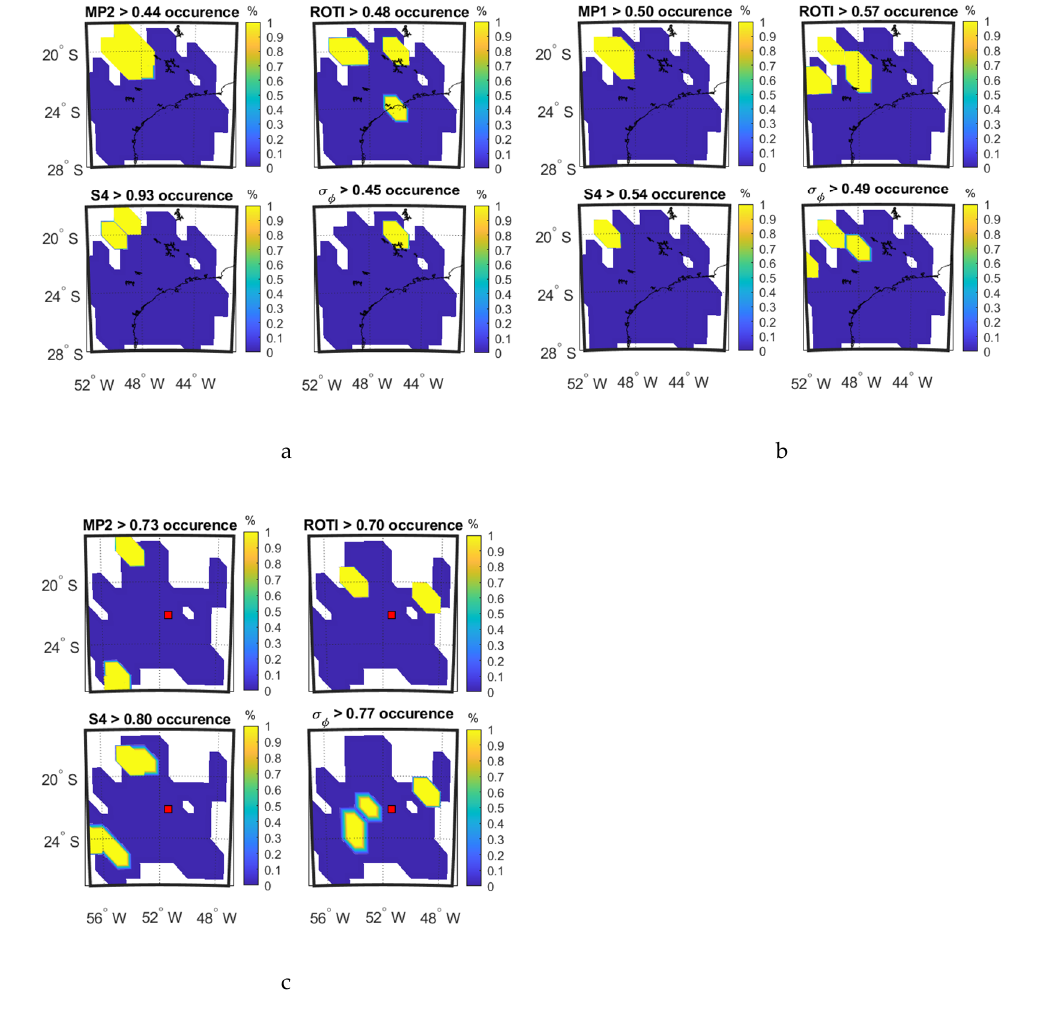
Figure 7. Occurrence percentage maps of four parameters: ( a ) during 00:00:00–06:00:00 UTC on Figure 7. xxxxxxxxxxxxxxxxx